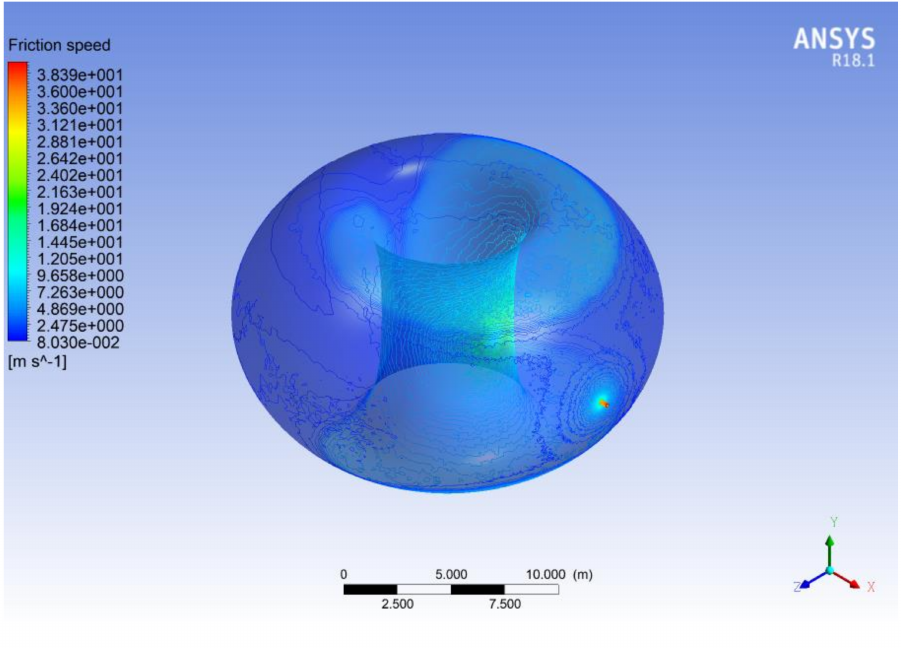
Figure 9. Friction speed at 3 × 10 − 2 s.